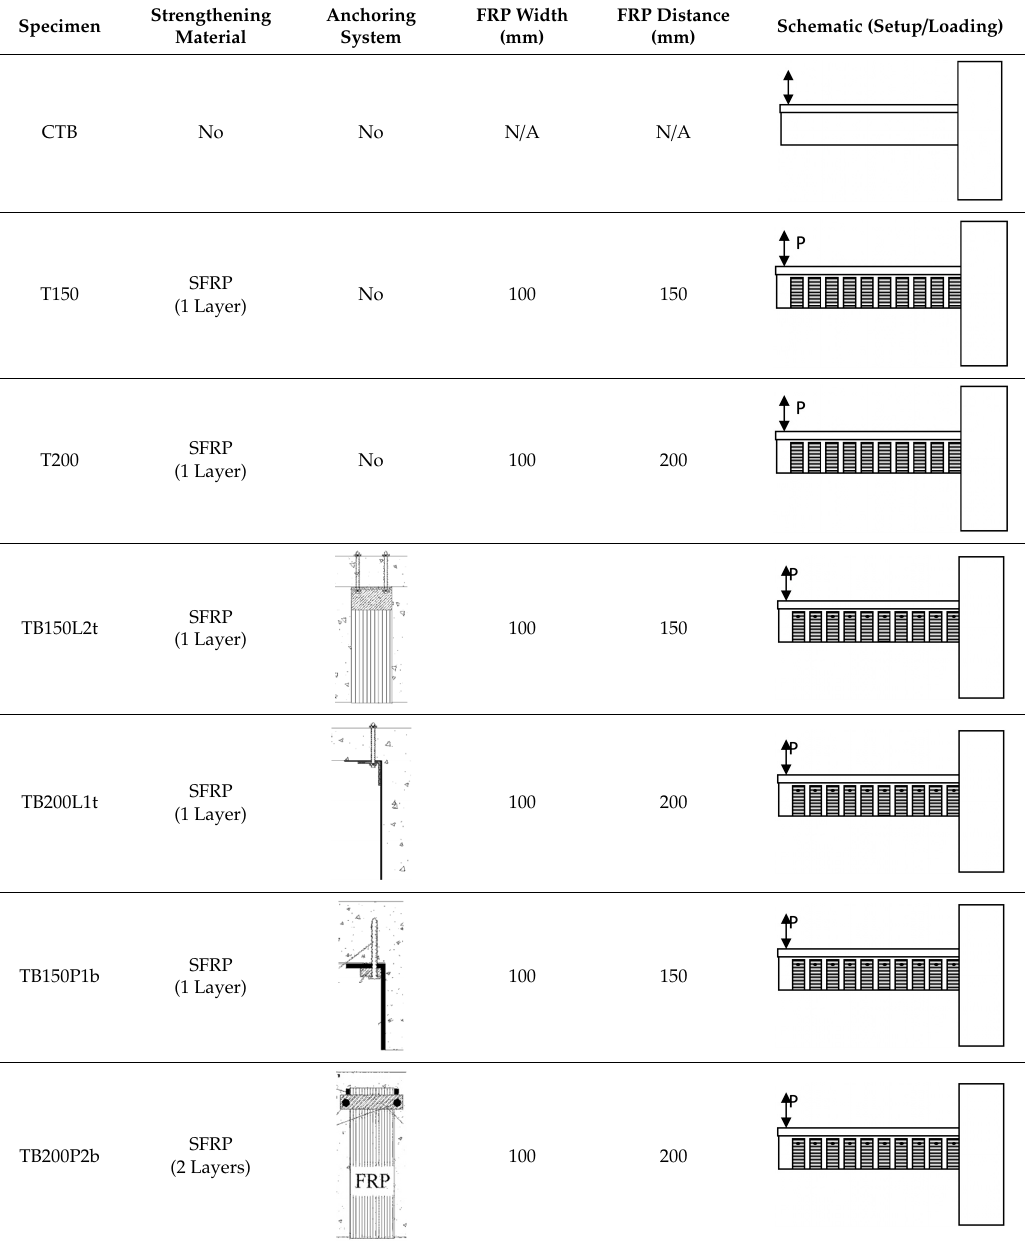
Table 1. Specimen details.